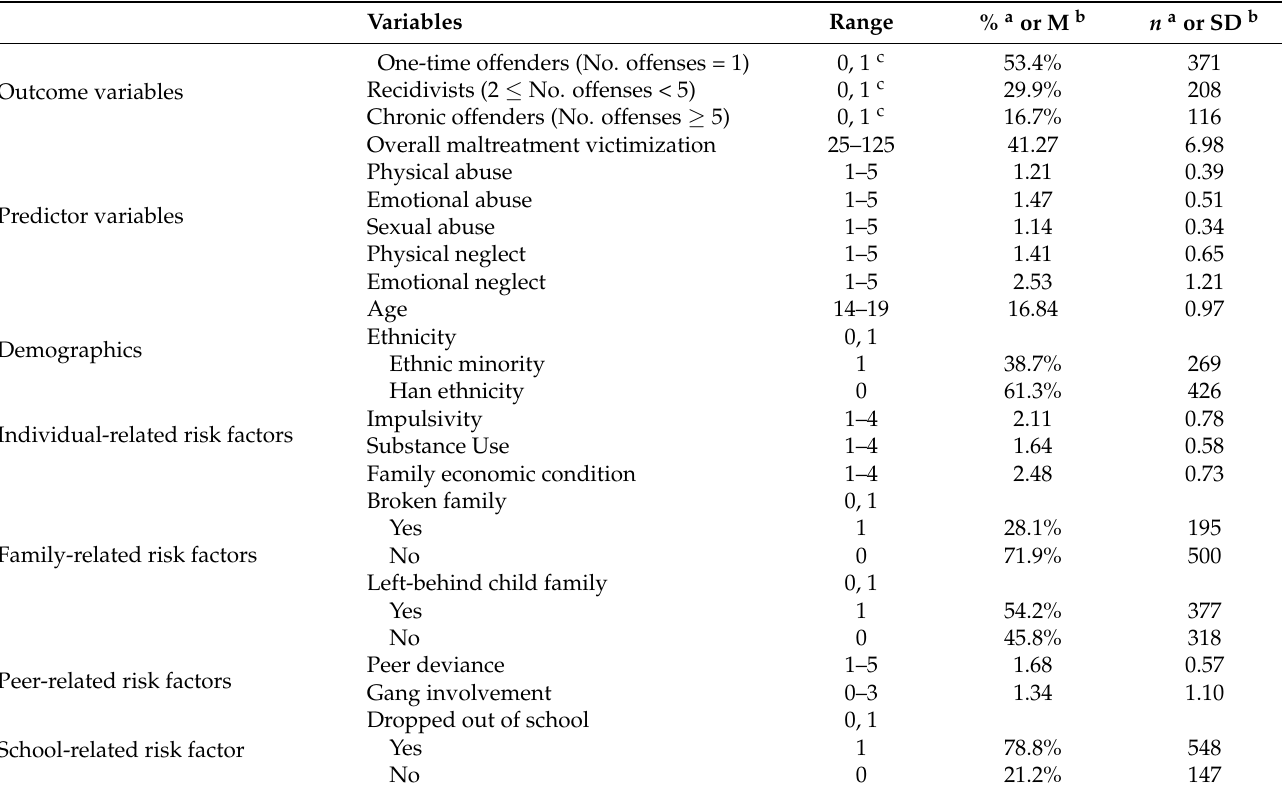
Table 1. Descriptive analysis of all variables included in the analyses (N =